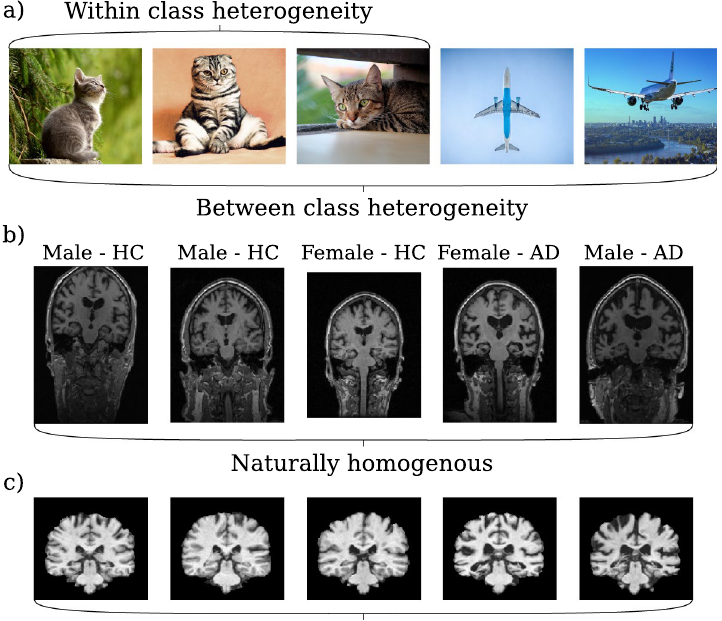
Figure 1. ( a ) Natural images are typically heterogeneous both within and between classes. ( b ) MR images of the human brain have homogeneous structures even among different sexes and between healthy subjects (HC) and diseased subjects (AD). ( c ) Through sophisticated pre-processing techniques, MR images are standardized to a common template reducing their variance